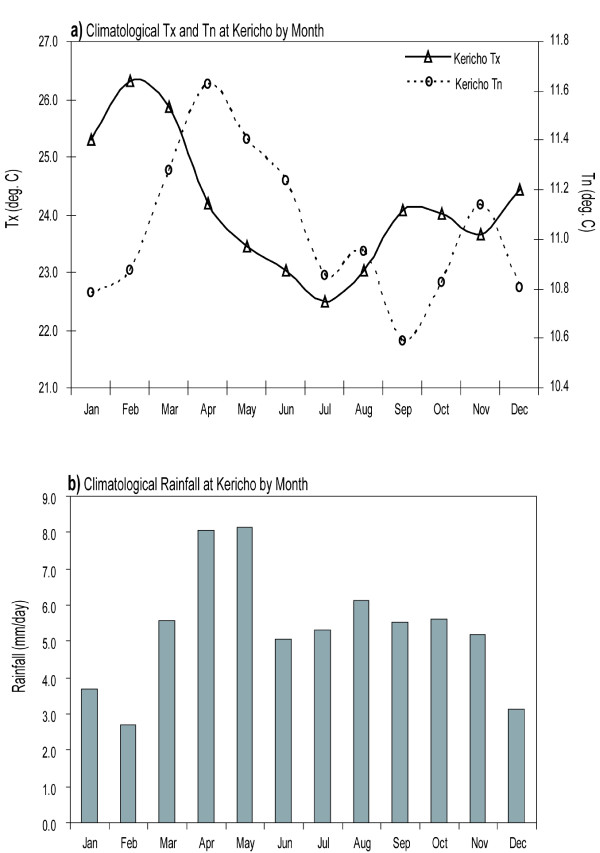
Average monthly climate conditions at Kericho for the period 1980-2009 a) lines indicate monthly average temperature (deg. C) Tx (left axis) and Tn (right axis) b) bars indicate average monthly rainfall (mm/day, left axis).